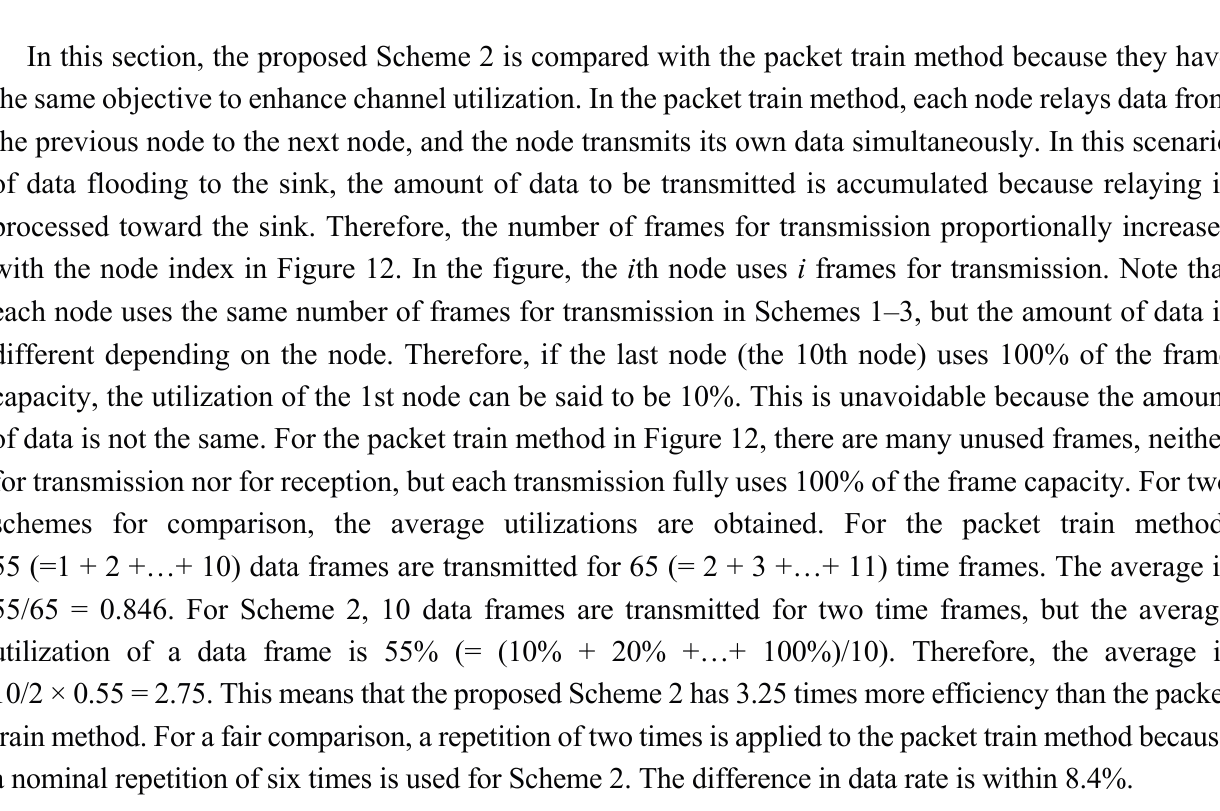
Figure 11. Target spot for underwater